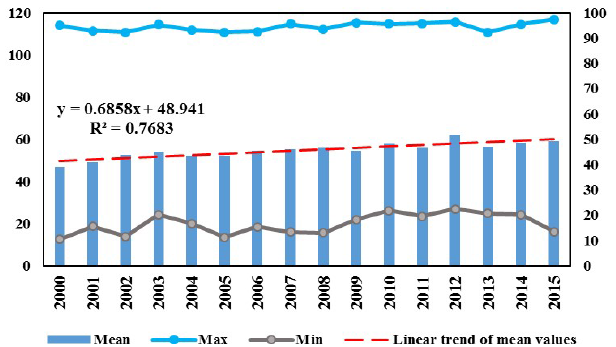
Figure 8. The value of maximum, minimum and mean of the VHI during